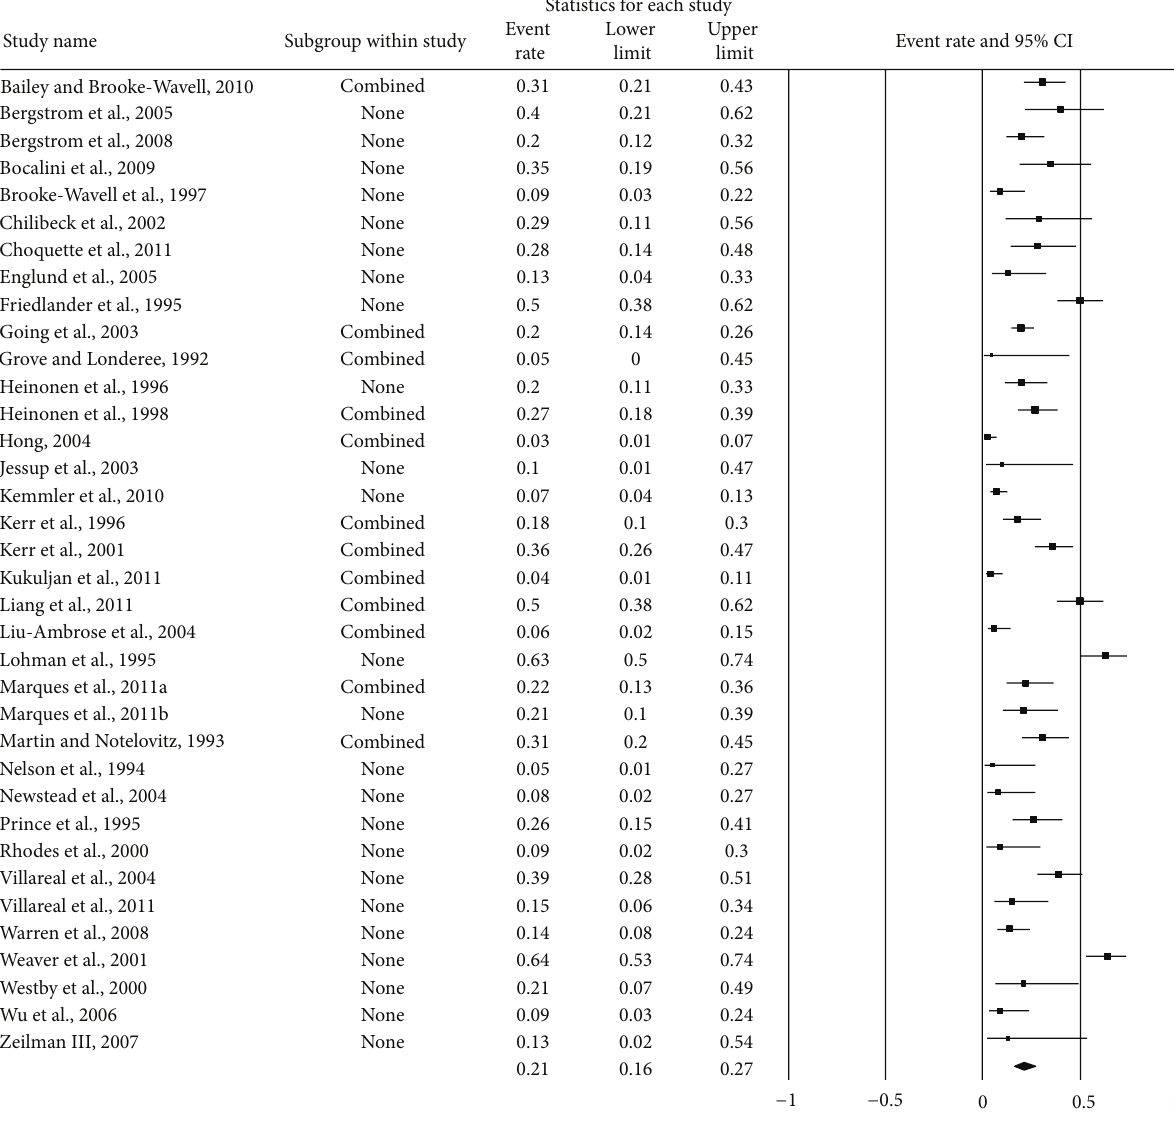
Figure 2: Forest plot for exercise dropouts (study level). Forest plot for exercise dropouts at the study level. The black squares represent the mean event rate while the left and right extremes of the squares represent the corresponding 95% confidence intervals. The middle of the black diamond represents the overall mean event rate while the left and right extremes of the diamond represent the corresponding 95% confidence